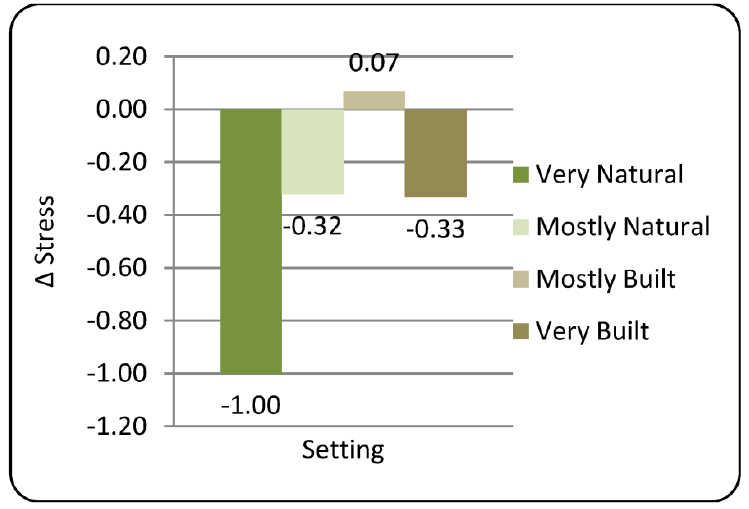
Figure 4. Changes in subjective stress (∆Stress) after 20 min exposure to environmental